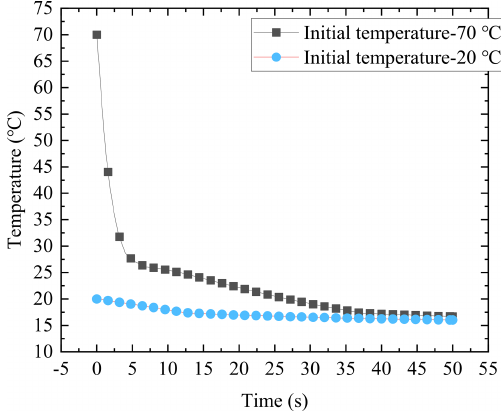
Figure 10. Cooling times at different initial